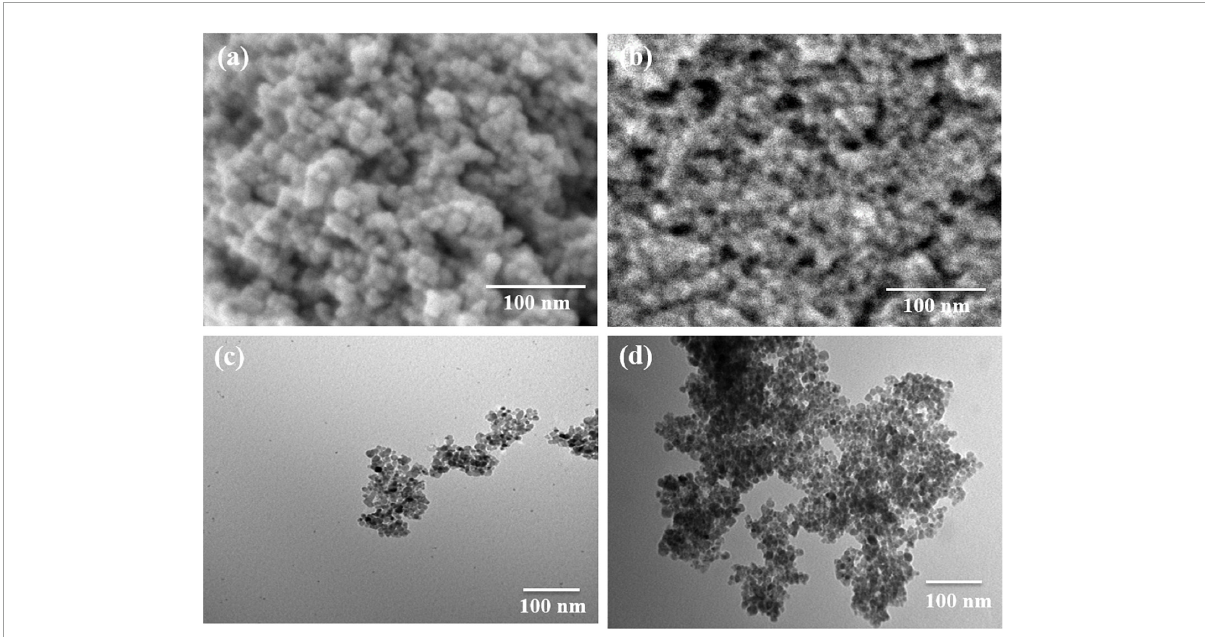
FIGURE1 Morphology of Fe 3 O 4 and CS-Fe 3 O 4 nanoparticles. (a) High-resolution scanning electron microscopy (SEM) image of Fe 3 O 4 nanoparticles. (b) High-resolution SEM image of CS-Fe 3 O 4 nanoparticles. (c) Transmission electron microscopy (TEM) image of Fe 3 O 4 nanoparticles. (d) TEM image of CS-Fe 3 O 4 nanoparticles.